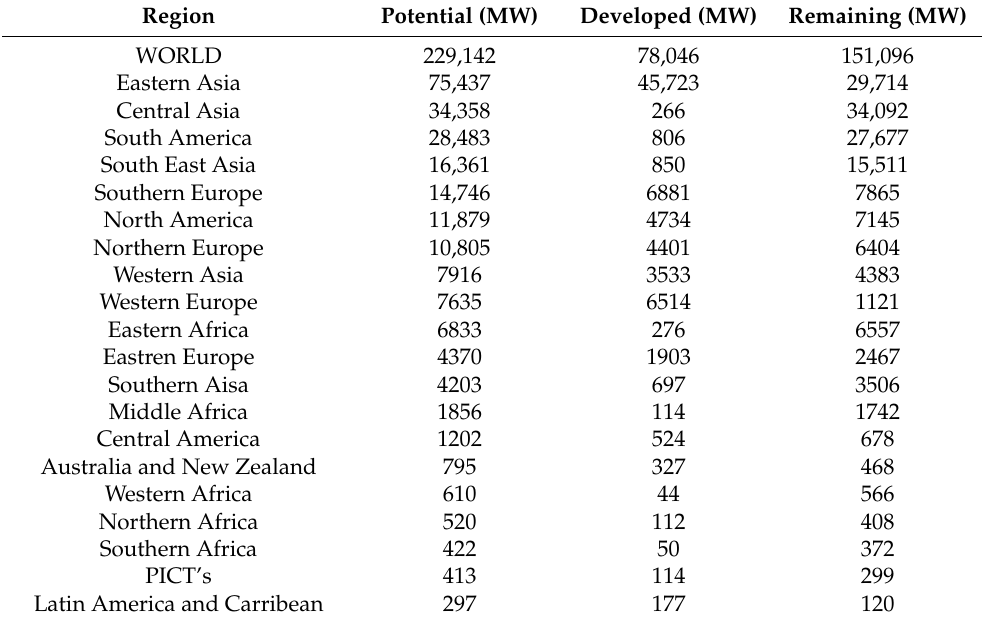
Table 2. Global SHP statistics